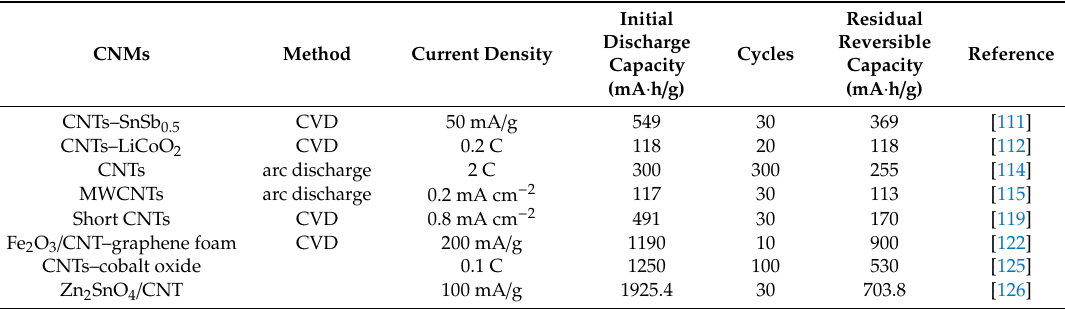
Table 6. TheelectrochemicalperformancesofCNTs-basedLi-ionbatteries.